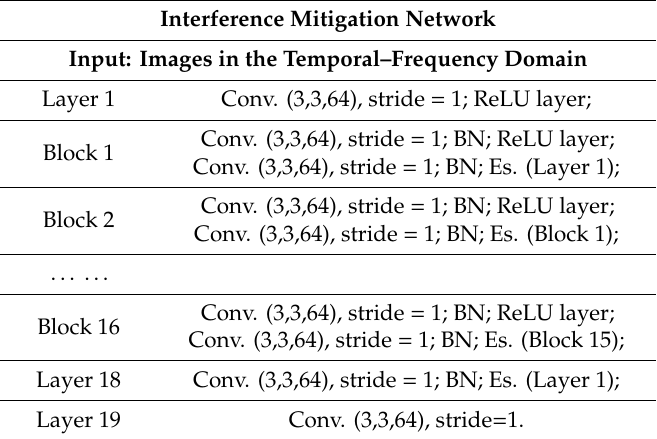
Table 2. The IMN